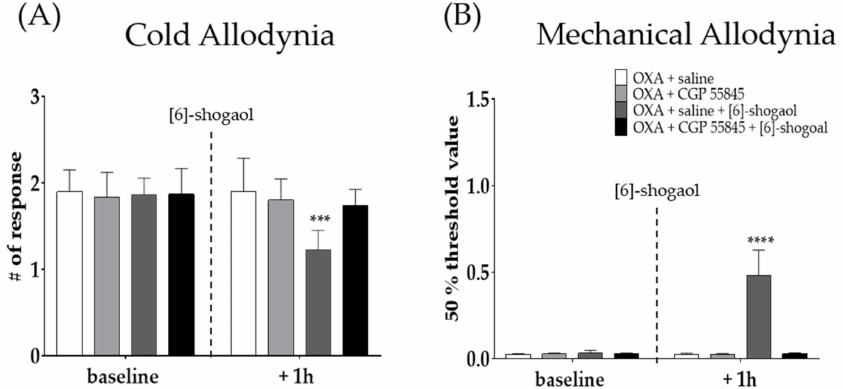
Figure 4. Intrathecal administration of GABA B receptor antagonist prevented the analgesic effect of [6]-shogaol in oxaliplatin-induced cold ( A ) and mechanical allodynia ( B ). CGP 55845 is GABA B receptor antagonist. Cold allodynia was assessed by using acetone drop test ( A ) and mechanical allodynia was measured by using von Frey filament test ( B ). All group received oxaliplatin injection four days prior to behavior test. Saline was used as control for CGP 55845. [6]-shogaol was intraperi- toneal injected 20 min after intrathecal injection of saline and CGP 55845. Baseline: before injection of saline, CGP 55845, and [6]-shogaol. +One h: 1 h after injection of saline, CGP 55845, and [6]-shogaol. Data are presented by mean ± SEM. OXA + saline: n = 5, OXA + CGP 55845: n = 5, OXA + saline + [6]-shogaol: n = 6, OXA + CGP 55845 + [6]-shogaol: n = 5. *** p < 0.001, **** p < 0.0001 vs. OXA + saline with two-way ANOVA followed by Tukey’s multiple comparisons